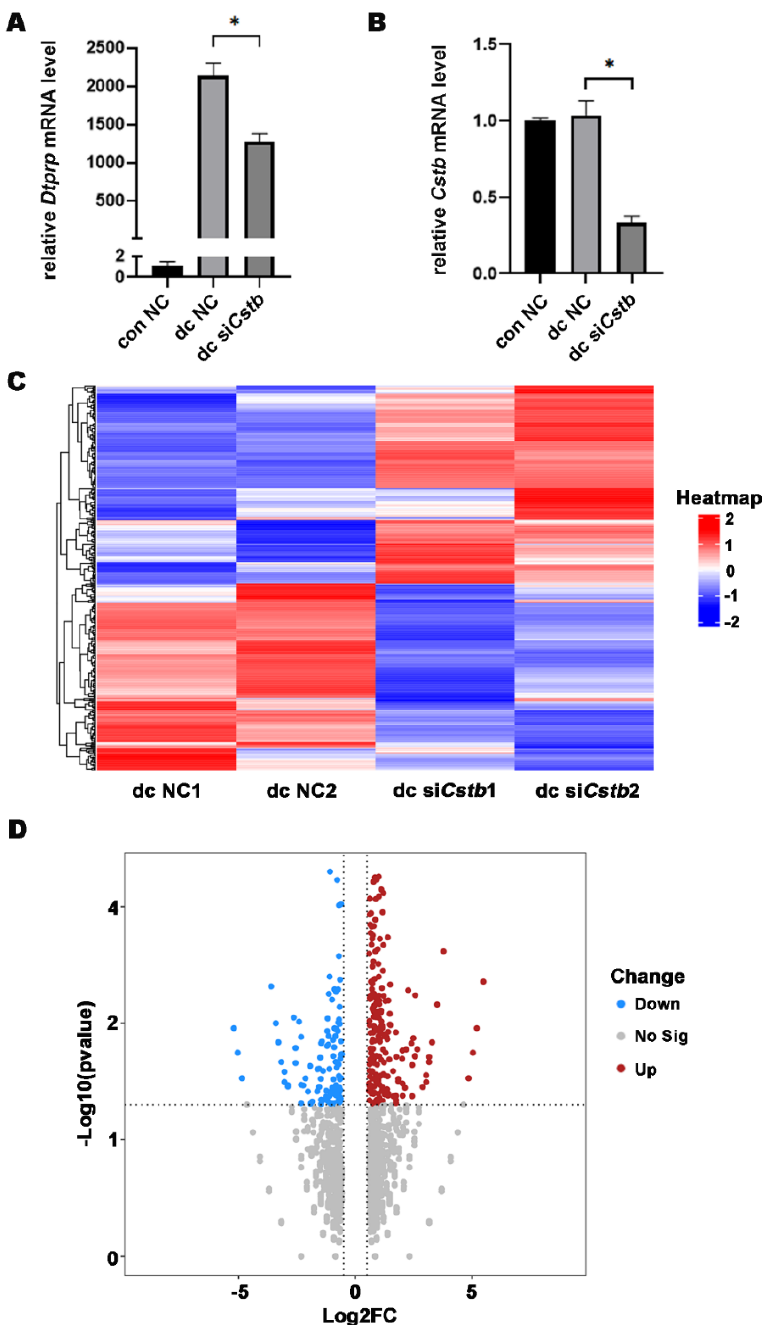
Figure 6. Cstb mRNA expression during in vitro decidualization. ( A ) Estrogen (10 nM) and progesterone (1 μ M) were used to induce decidualization of primary mouse endometrial stromal cells for 48 h after RNA interference in mouse stromal cells for 6 h. The expression of Dtprp was detected by RT-qPCR. * p < 0.05. ( B ) RT-qPCR analysis on the effect of Cstb siRNA on Cstb mRNA level in stromal cells. ( C ) Heat map showing hierarchical clustering of gene expression in dc NC group and dc si Cstb group. Differentially expressed genes were screened according to Log2 (Fold Changes) > 0.25 or <-0.25 and p -value < 0.05. Red and blue depict high and low levels of gene expression, respectively. ( D ) Volcanic maps show differential expression of genes in the dc NC group versus the dc si Cstb group. The upregulated gene (red); the downregulated gene (blue). NC, negative control; si Cstb , siRNA of Cstb ; dc, in vitro decidualization.